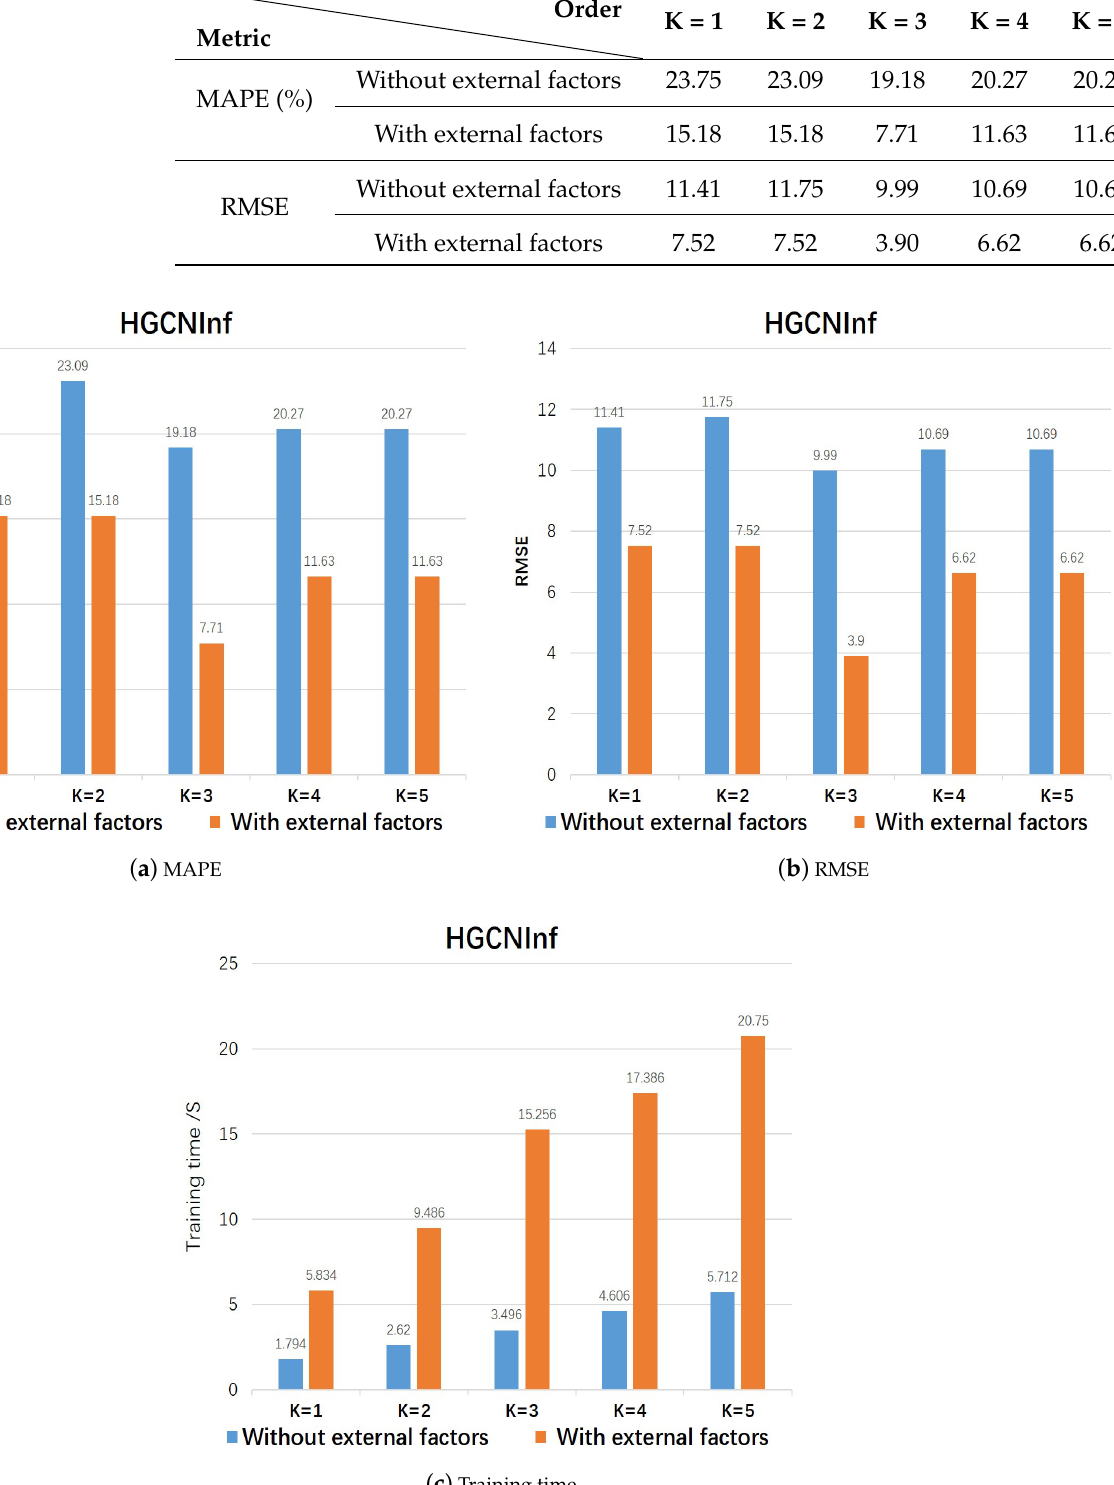
Table 4. The HGCNInf performance of different orders.